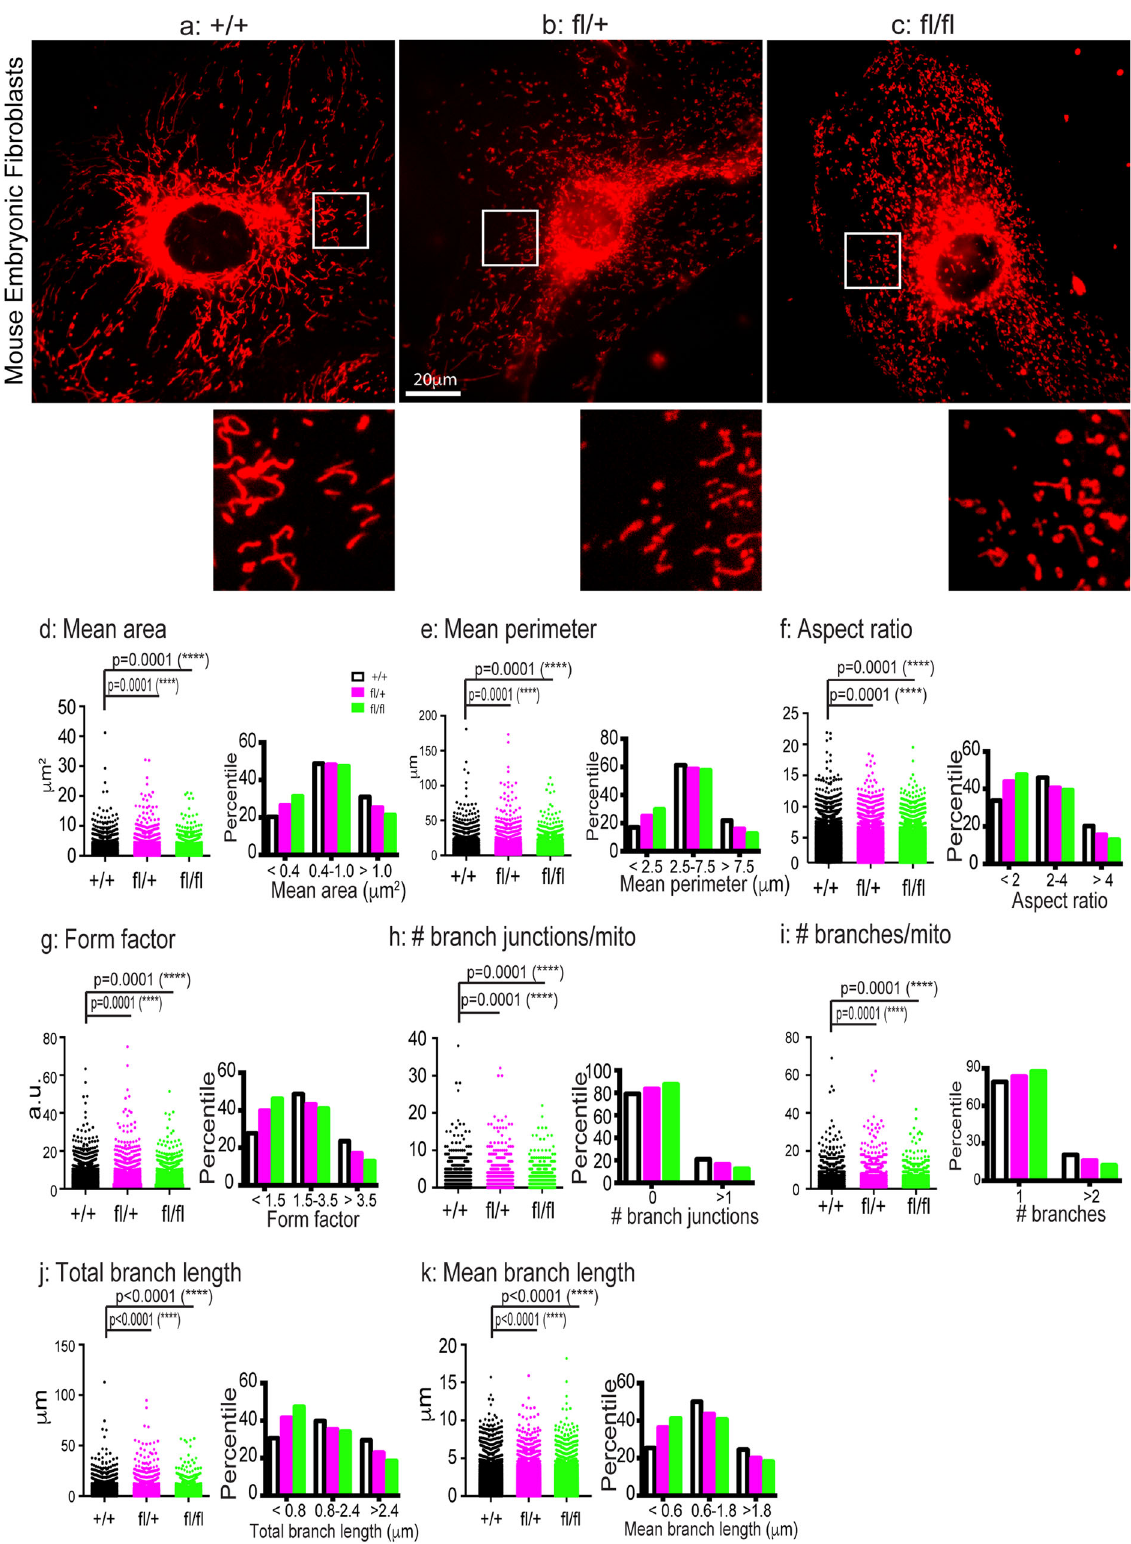
morphological changes of mitochondria were more pronounced in the fl / fl cells than the fl / + cells (Fig. 2d – g), suggesting a gene- dosage dependent effect. These data are consistent with our human fi broblast results (Fig. 1). We thus conclude that expression of Rab7 V162M mutant allele at physiological conditions induces signi fi cant mitochondrial